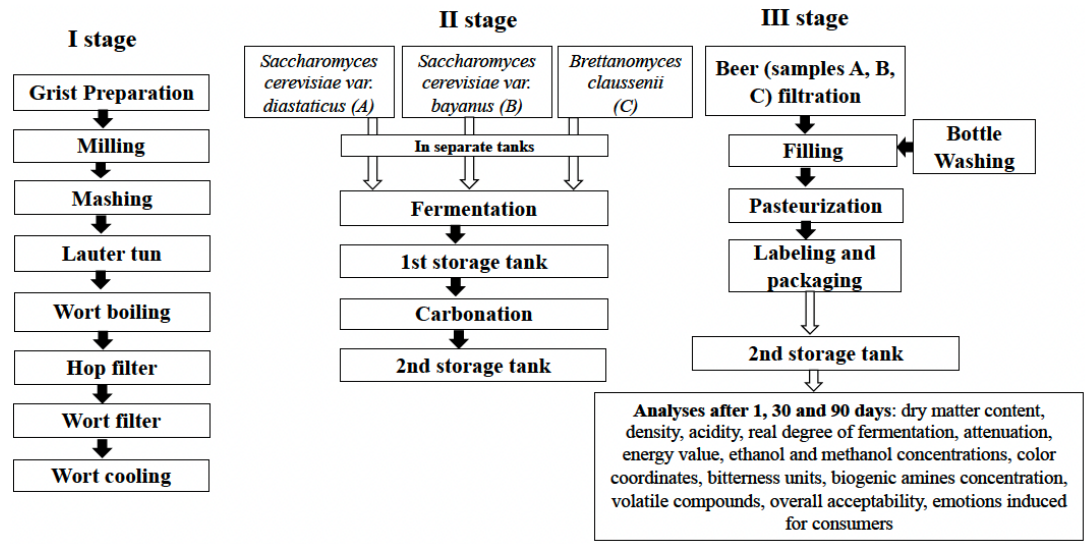
Figure 1. Principal technological scheme for the beer preparation. After boiling, the wort is filtered, chilled and transferred to fermentation vessels (FUP 2 × 100, Plevnik, Dobrova, Slovenia). Three fermentation tanks were filled with the same wort to the same volume and temperature, then three different yeast strains (A, B, C) were pitched into each. The fermentation was carried out at 21 – 23 °C temperature.